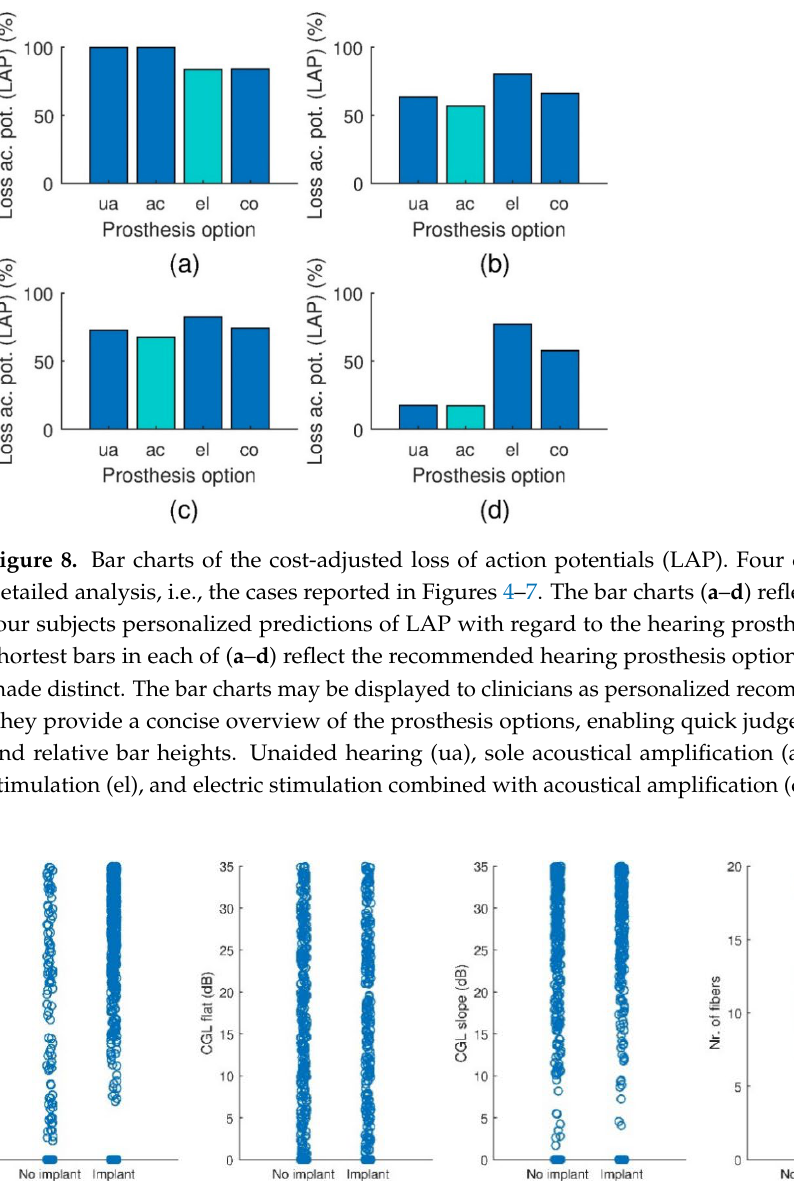
Figure 9. Hearing loss parameters Ψ = { I f ,I s ,O f ,O s ,N fib } with regard to implantation recommendation. Shown are ( a ) the flat and ( b ) sloping components of the loss of IHCs, i.e., I f and I s ; ( c ) the flat and ( d ) sloping components of the cochlear gain loss, i.e., O f and O s ; and ( e ) the average number of active fibers per IHC N fib , reflecting cochlear